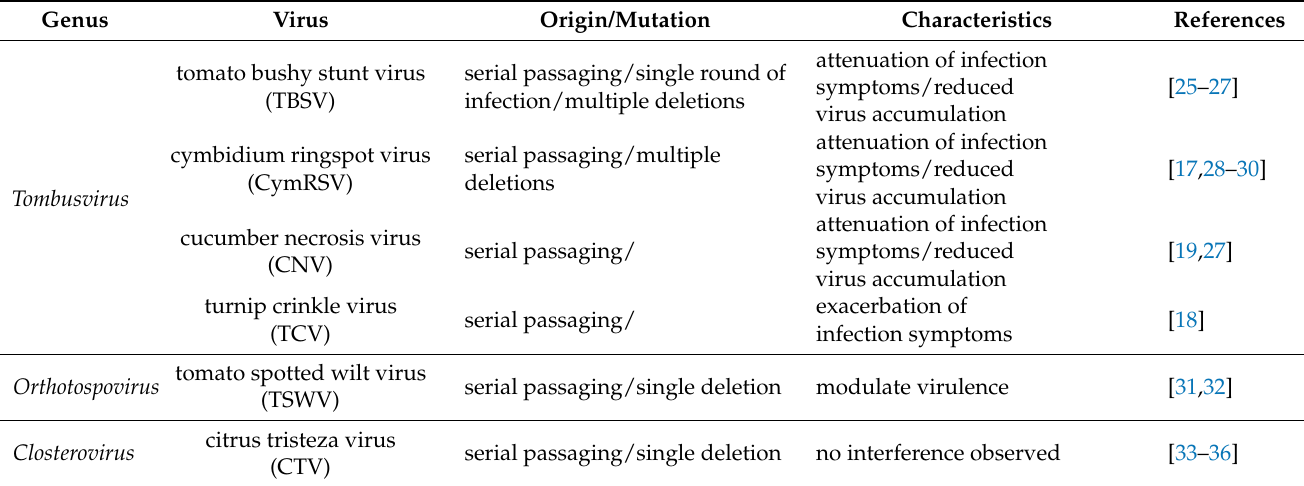
Table 1. Different species of D/DI RNAs associated with plant viruses. Genus